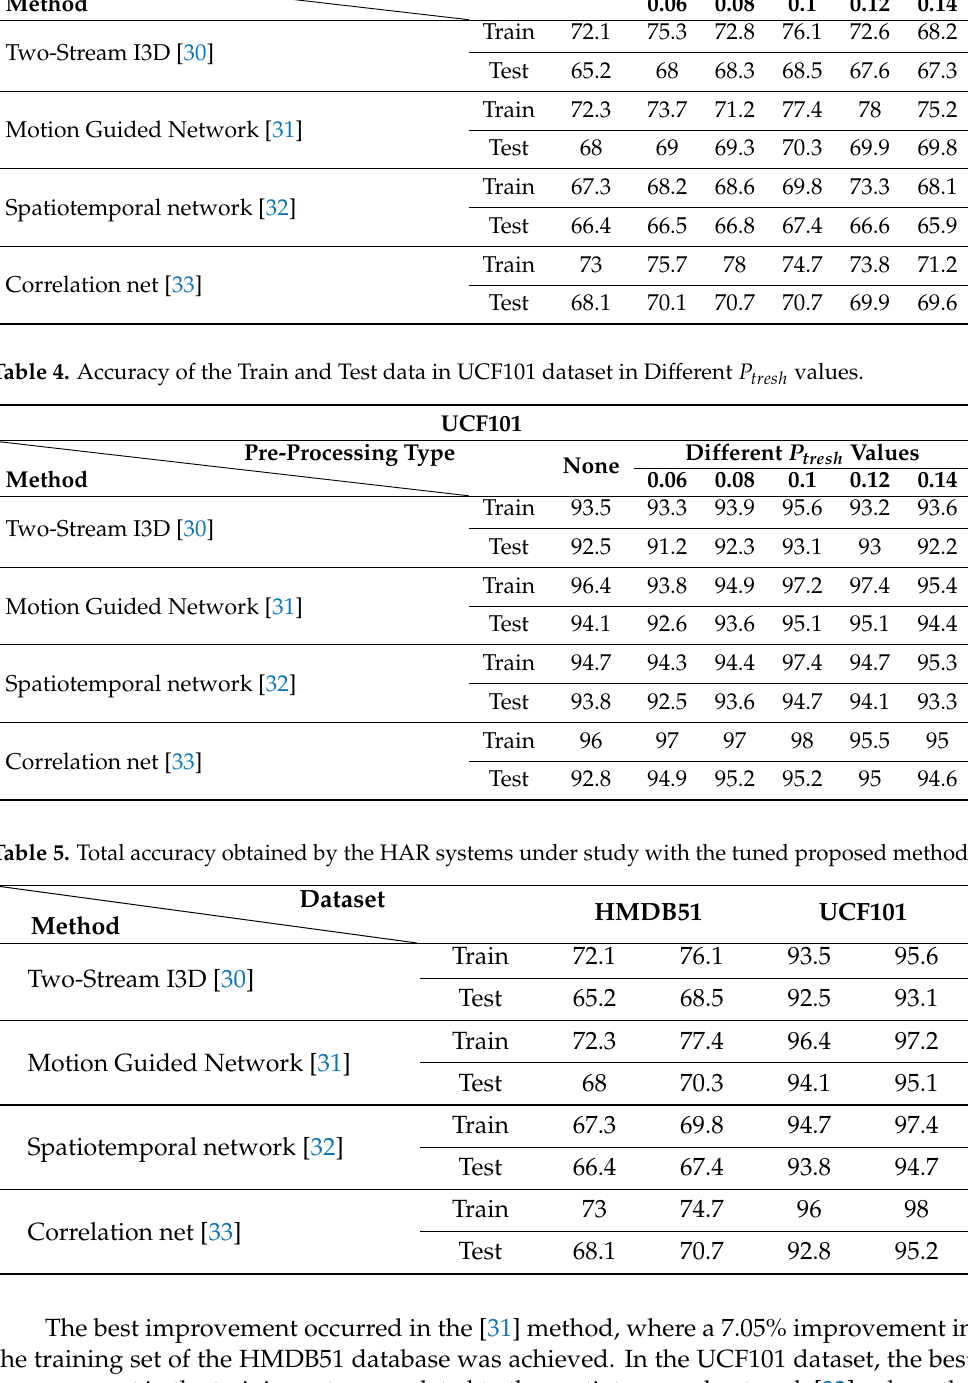
Table 3. Accuracy of the Train and Test data in HMDB51 dataset in Different P tresh values.